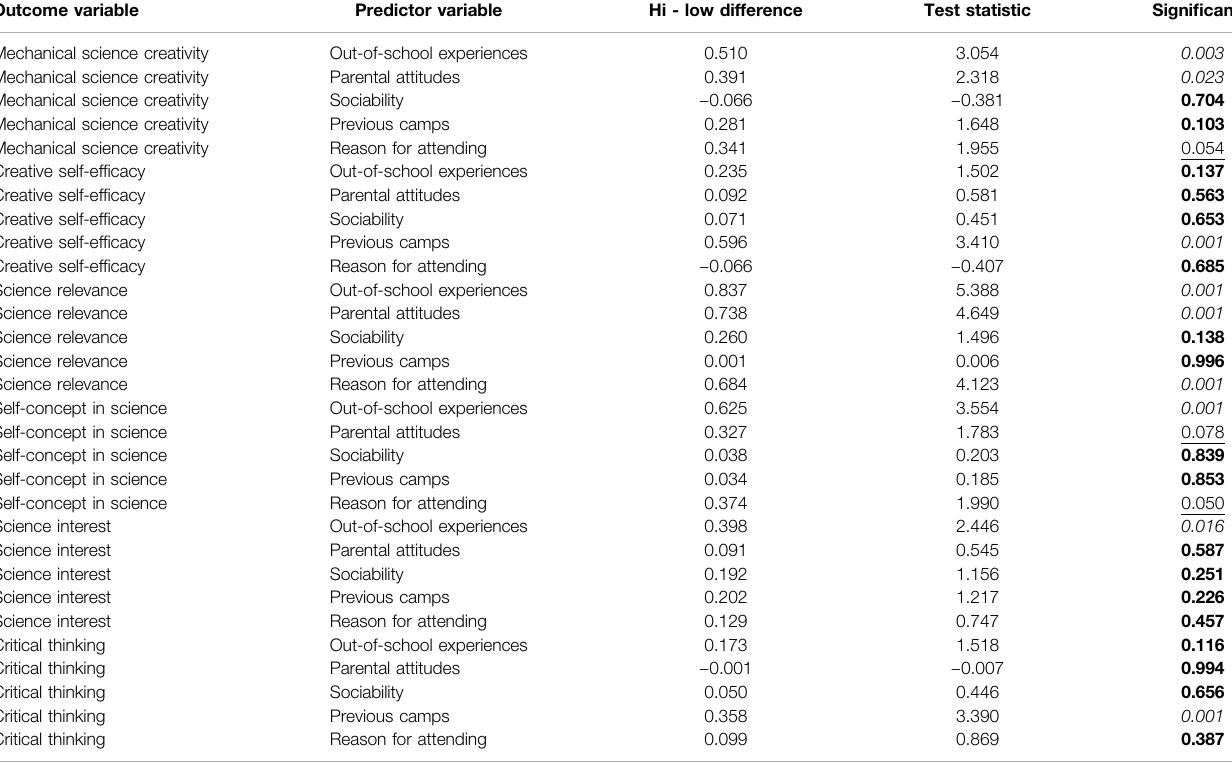
TABLE 4 | Current participant differences in T3 Outcome variable scores as a function of high/low T1 Potential Indicator variables. Outcome variable Predictor variable Hi - low difference Test